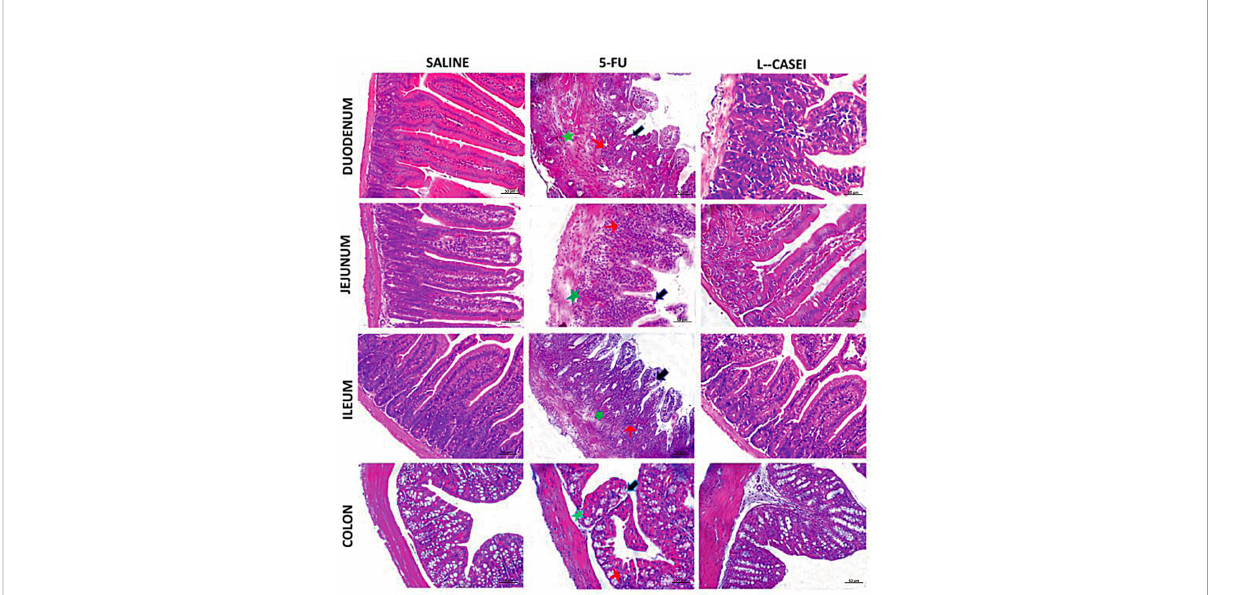
FIGURE 2 Histophatological analysis. Lacticaseibacillus casei (LC), prevented 5-FU-induced histopathological injuries in duodenum, jejunum, ileum and colon. 5-FU induces villi shortening (black arrows), loss of crypt architecture (green arrows) and intense in fl ammatory cell in fi ltrate (red arrows) in the duodenum, jejunum, ileum and colon, and edema (brown arrows) in the colon submucosal layer. H&E; scale bar corresponds to